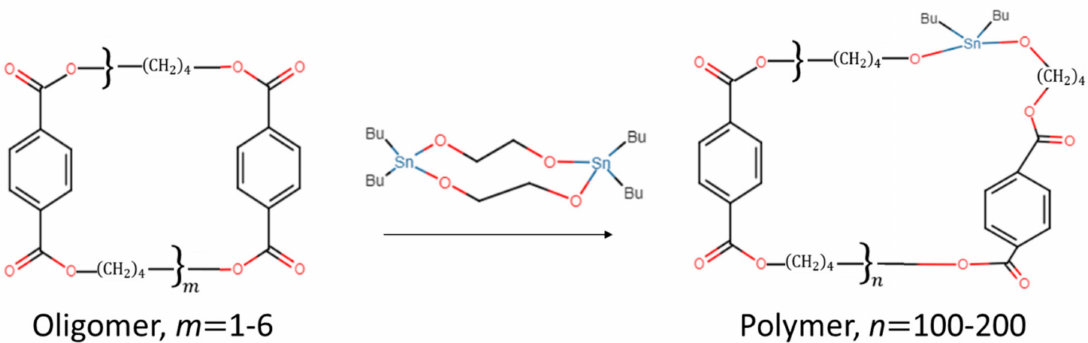
Figure 1. Incorporation of tin into a macrocyclic structure via the cyclic